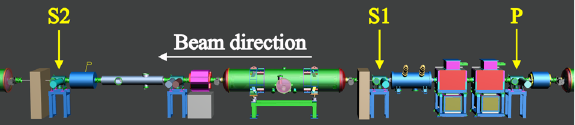
FIG. 3. Simulation model for the thermomechanical analysis of the primary collimator. FIG. 4. Location of the collimation system in